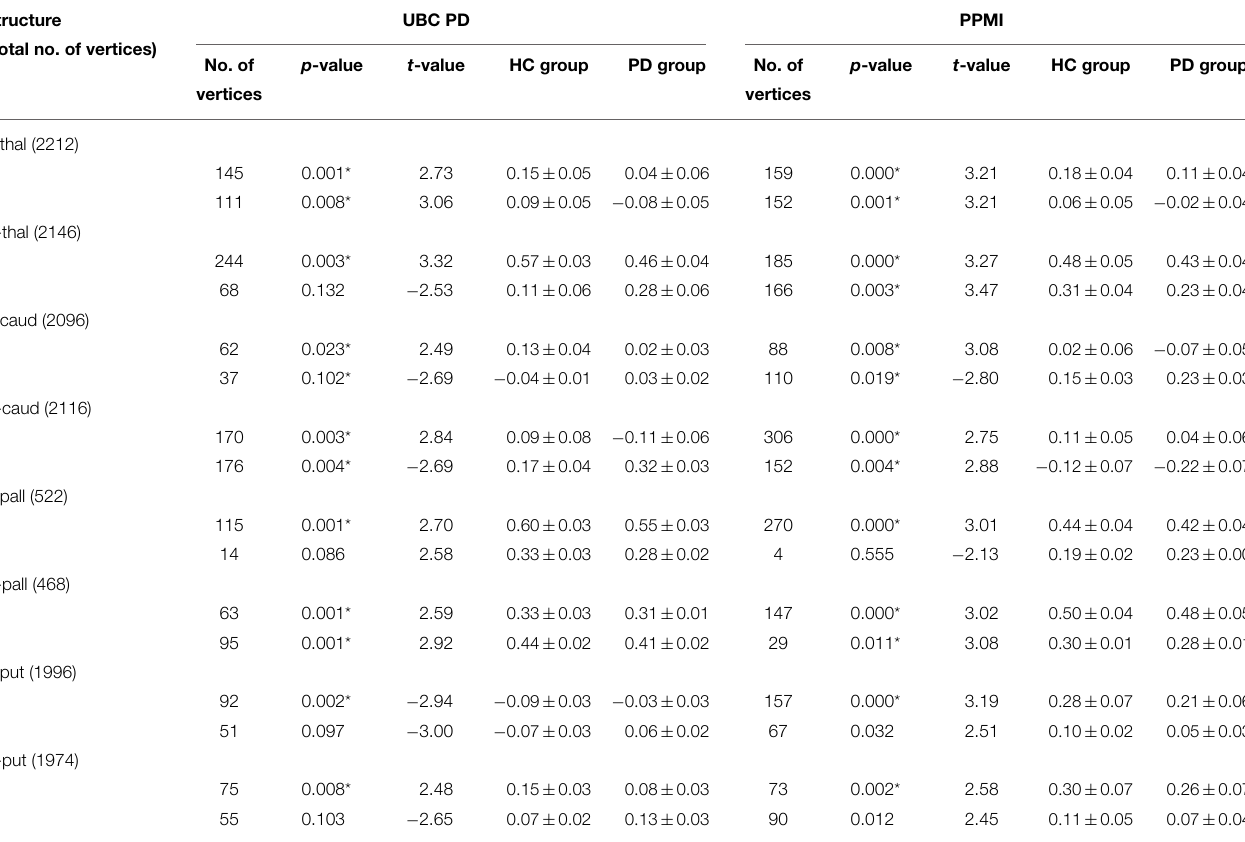
TABLE 4 | Results for the vertex-wise group difference in the surface displacement (affine pre-registered) between Parkinson’s disease patients [ n = 55 ( UBC ), n = 189 ( PPMI )] and healthy controls [ n = 54 ( UBC ), n = 137 ( PPMI )] for 8 subcortical structures.